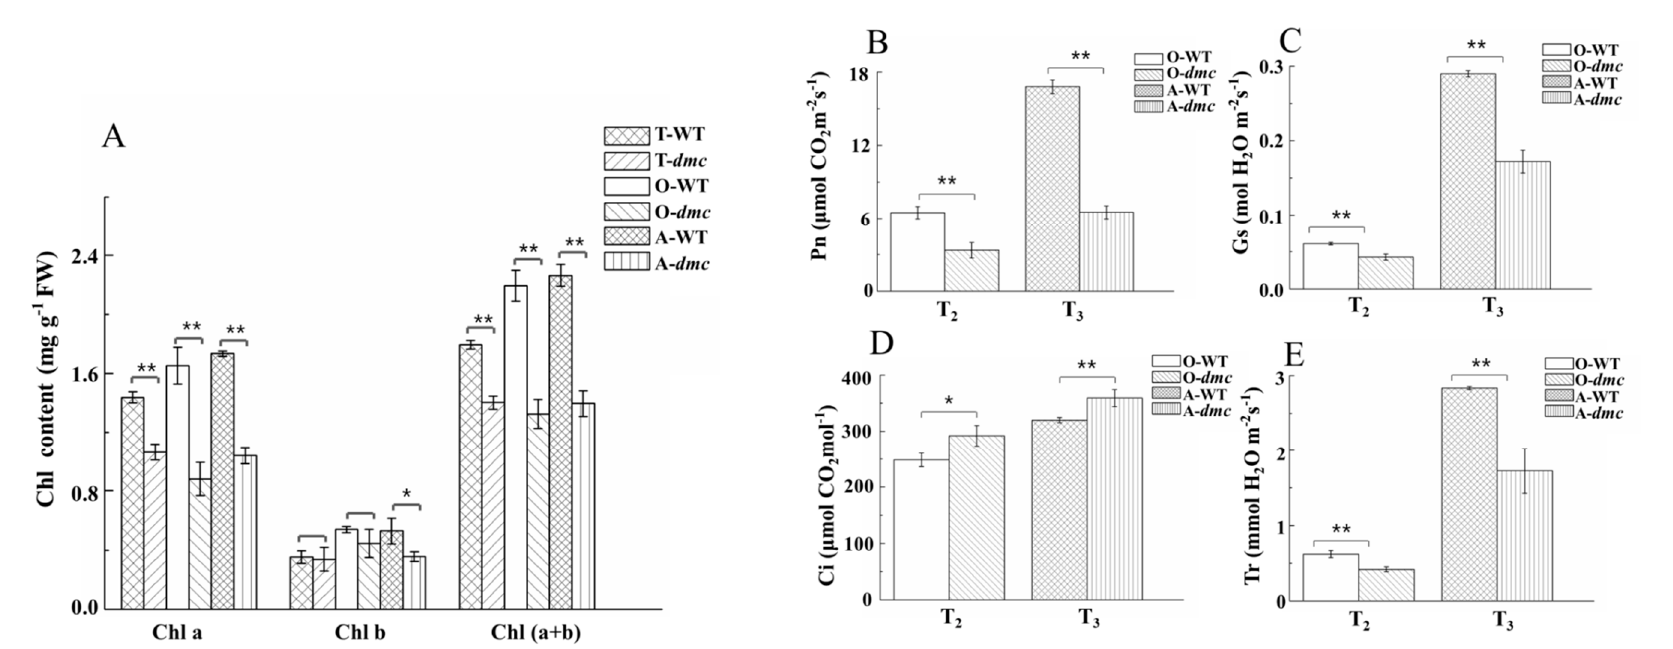
Figure 5. The chlorophyII contents and photosynthetic parameters of the fully expanded main-stem leaves of dmc and WT during tillering. (A ) Leaf chlorophyII content. Chl a, the content of chlorophyII a; Chl b, the content of chlorophyII b; Chl (a + b), the content of chlorophy II a + b. ( B – E ) Leaf photosynthesis parameters. Each bar represents the mean ± SD of three biological replicates. Asterisks indicate a statistically significant difference between dmc and WT at the same stage (*: P ≤ 0.05, **: P ≤ 0.01). T-WT: WT at the three-leaf stage; T- dmc : dmc at the three-leaf stage; O-WT: WT at the over-winter stage; O- dmc : dmc at the over-winter stage; A-WT: WT between the rising to jointing stage; A- dmc : dmc between the rising to jointing stage.